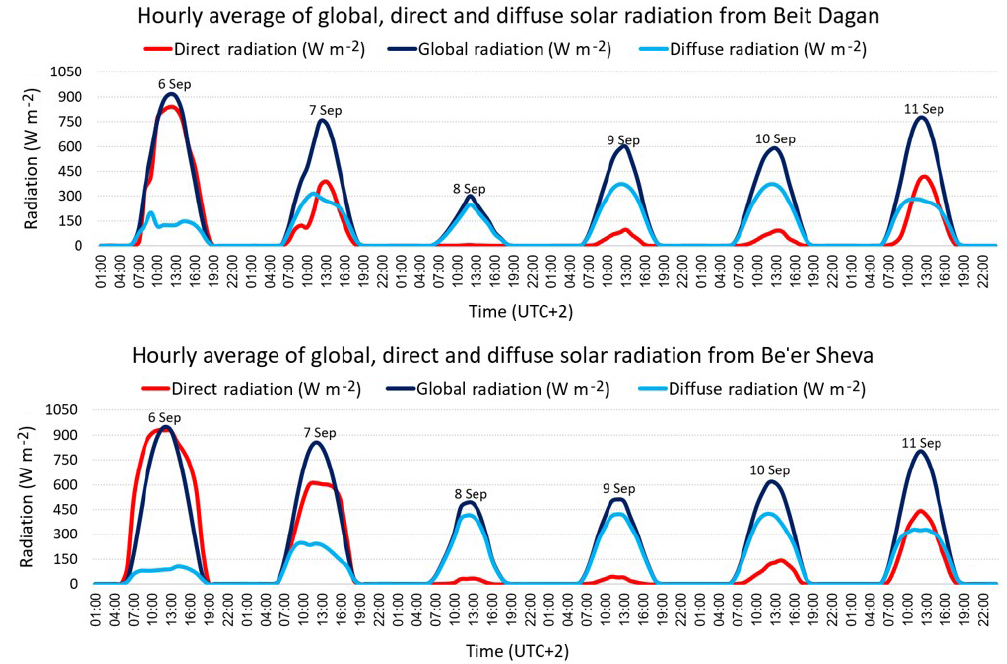
Figure 18. Hourly average of global, direct and diffuse solar radiation between 6 and 11 September 2015 from Beit Dagan and Be’er Sheva.